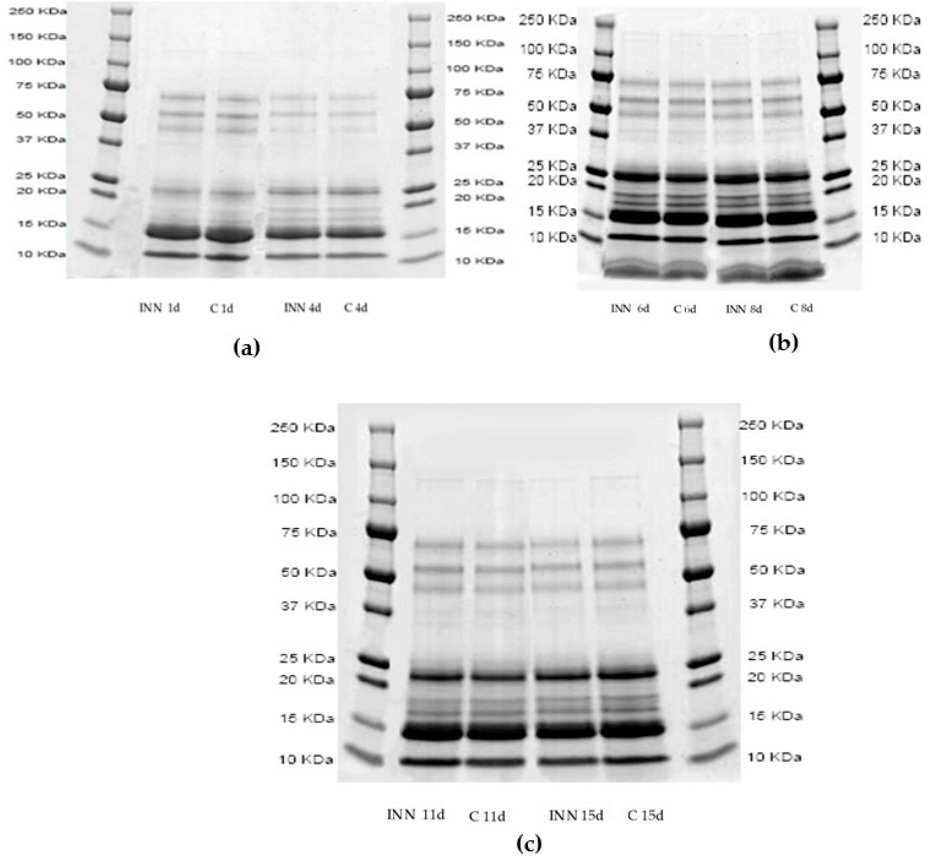
Figure 1. Sodium dodecyl sulfate–polyacrylamide gel electrophoresis profiles of pH 4.6 soluble fractions of traditional (C) and innovative (INN) Squacquerone cheeses after 1 and 4 ( a ), 6 and 8 ( b ), and 11 and 15 ( c ) days.